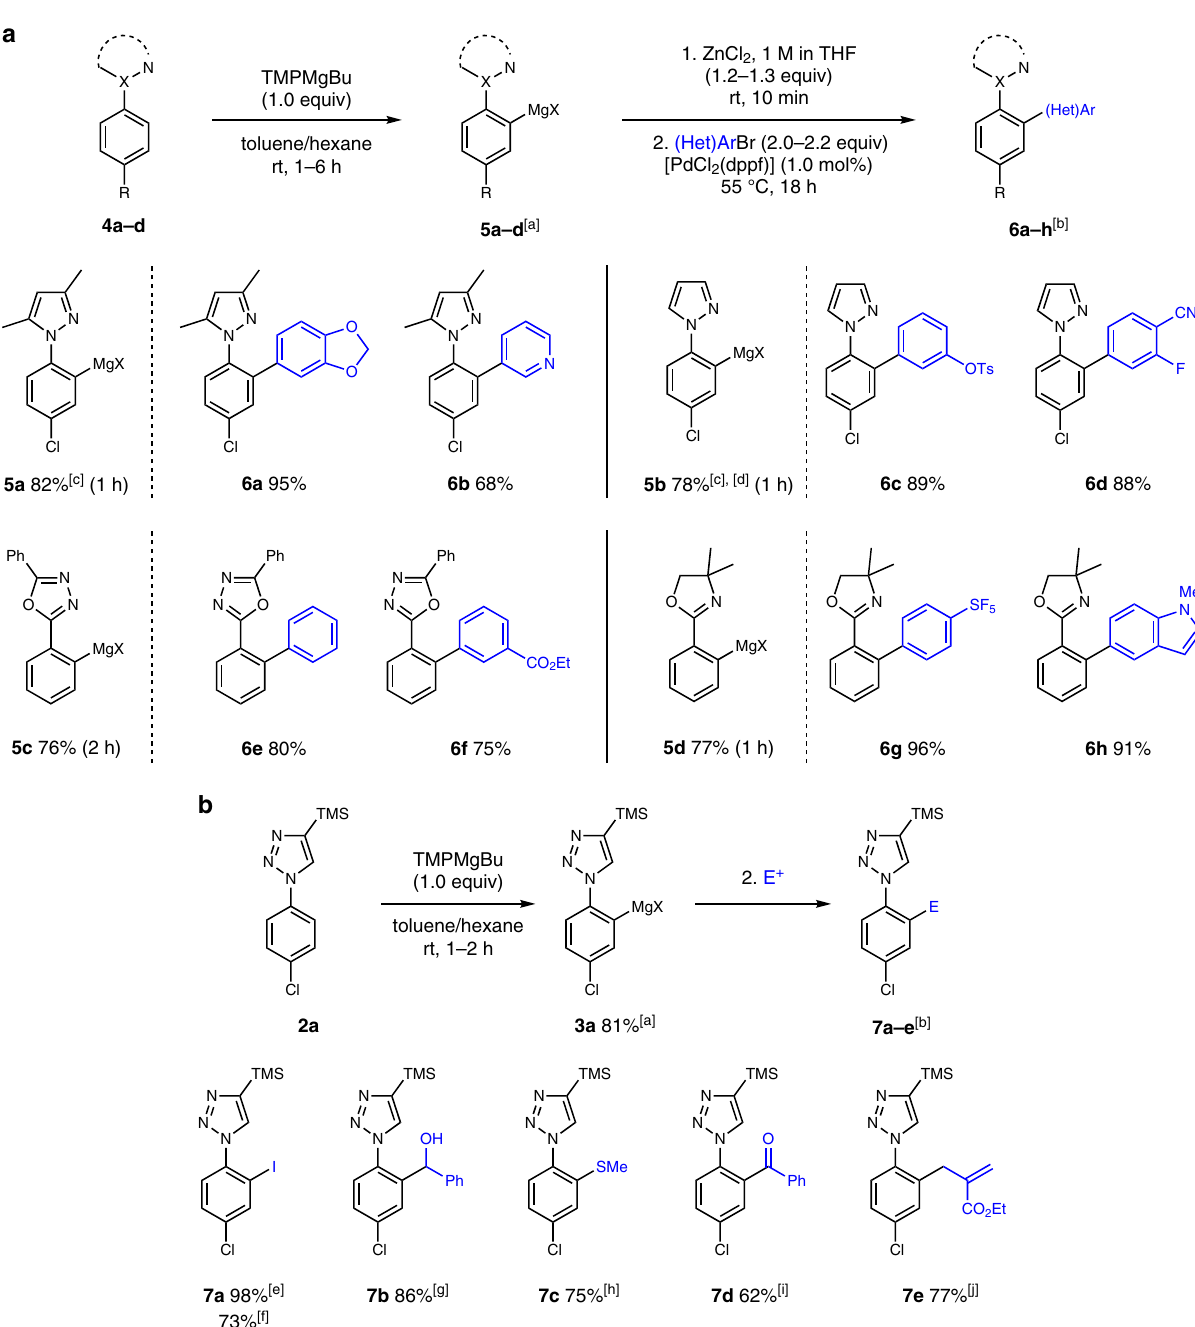
intermediate and several late-stage modi fi cations demonstrated the versatility of the resulting products. Mechanistic experiments highlighted the key role of TMP for the reactivity of the resulting organomagnesium reagents in cross-coupling reactions.